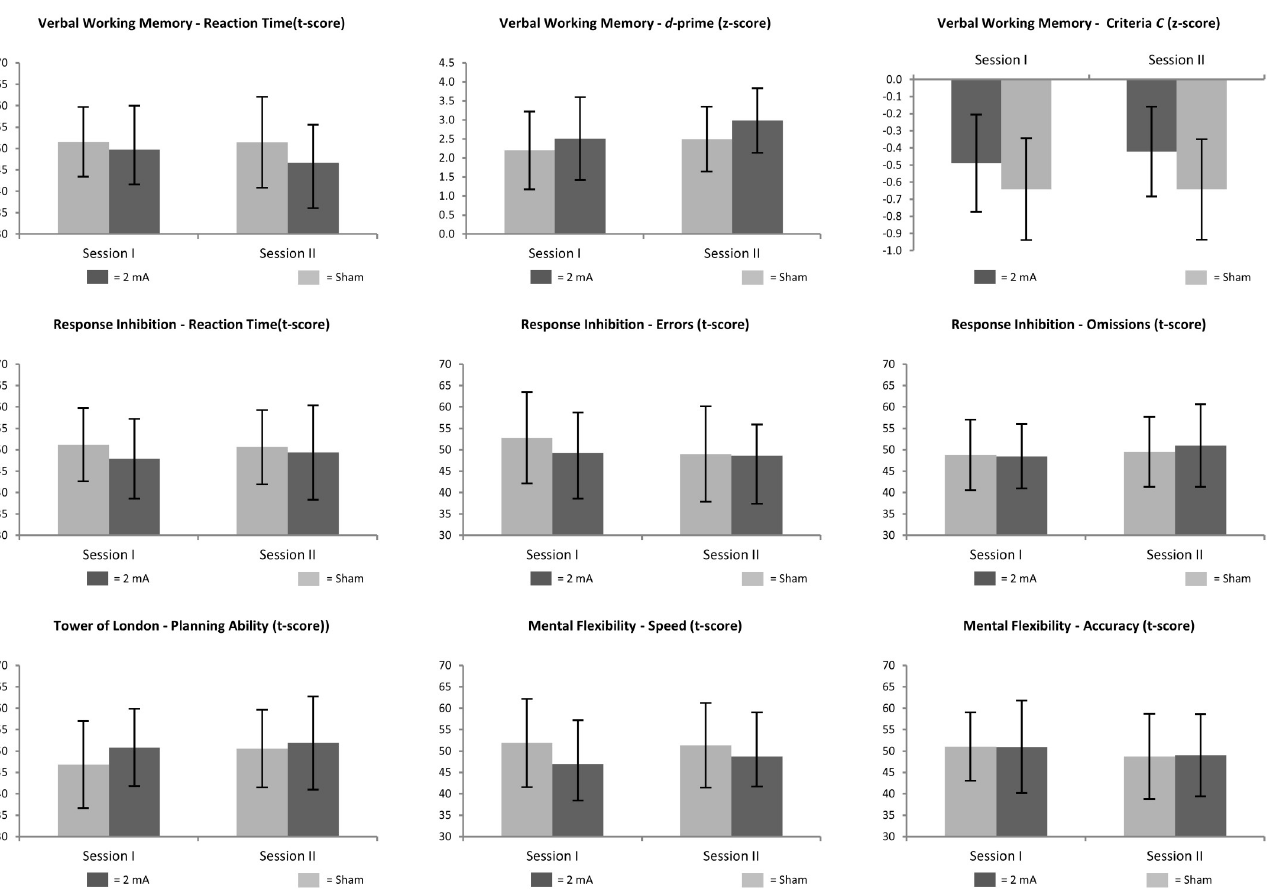
Fig 2. Neuropsychological performance in session 1 and session II separated by group (2 mA verum vs. sham stimulation)—Results of the main analysis. Standardized data (t-scores and z-scores) of neuropsychological performance of the verbal working memory, response inhibition, mental flexibility and planning ability task separated by time of measurement and group (black = 2 mA of tDCS over the left DLPFC, grey = sham condition). Depicted is the respective group mean together with the standard deviation. Note, lower t-scores indicate better performance except for the planning ability task where higher t-scores indicate better performance. For d -prime and the response criteria C z-scores are presented where higher d -prime values indicate better performance and higher C values indicate a more conservative response decision.